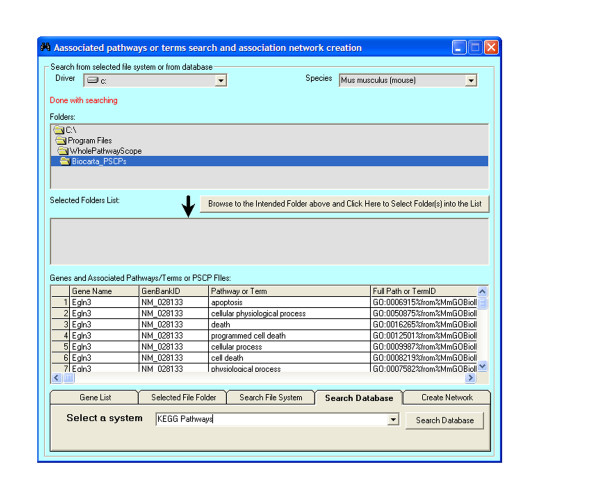
The window for generation of gene-term association network. The gene list derived from pattern extraction in Fig. 6 was copied and pasted into this window. GO:Biological Process, Biocarta, and KEGG pathways were searched with the gene list and results were entered into the table in a gene-term pairwise format.